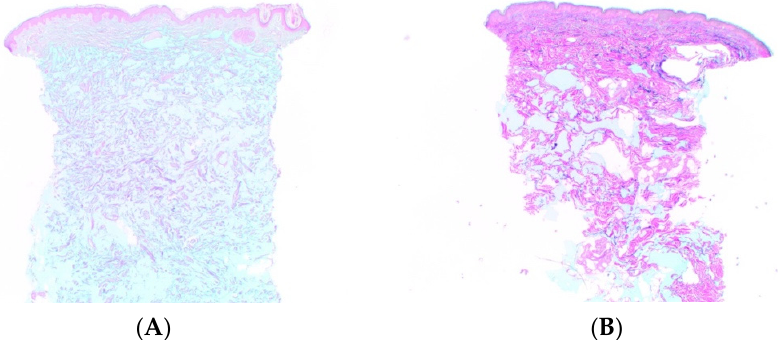
Figure 3. Histologic findings in superficial and mid-reticular dermis in ( A ) a liquid gel (CPM technology) vs. ( B ) a more elastic gel (Vycross) at 15 days post-injection. Magnification ×12.5. Reprinted/adapted with permission from Ref. [68]. Copyright 2017, Matrix Medical Communications.